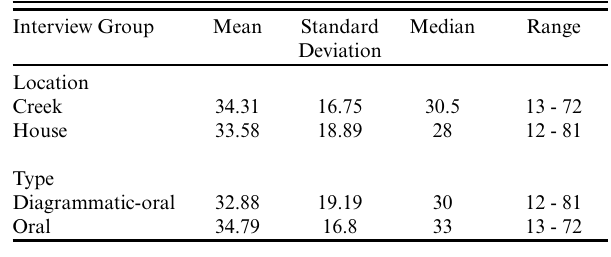
Table 2 . Mean and median number of functional linkages elicited using the different interview procedures.